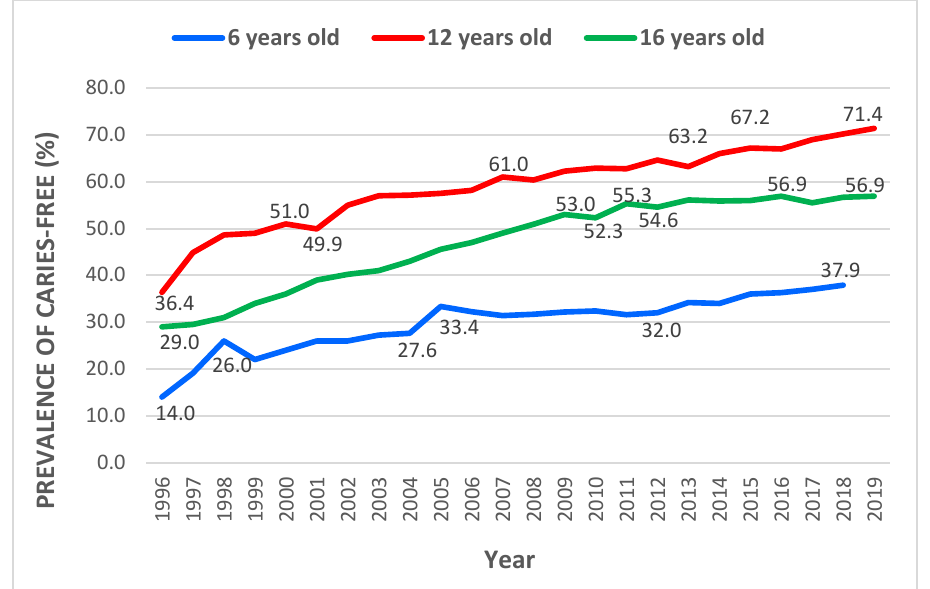
Figure 1. Trend of caries-free prevalence among six-year-old schoolchildren (1996–2018) and among 12- and 16-year-old schoolchildren (1996–2019) in